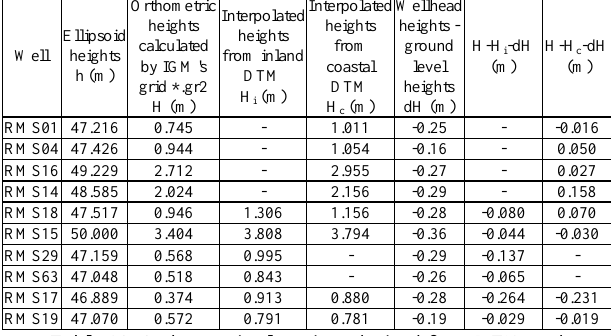
Table 10. Orthometric elevations derived from DTM